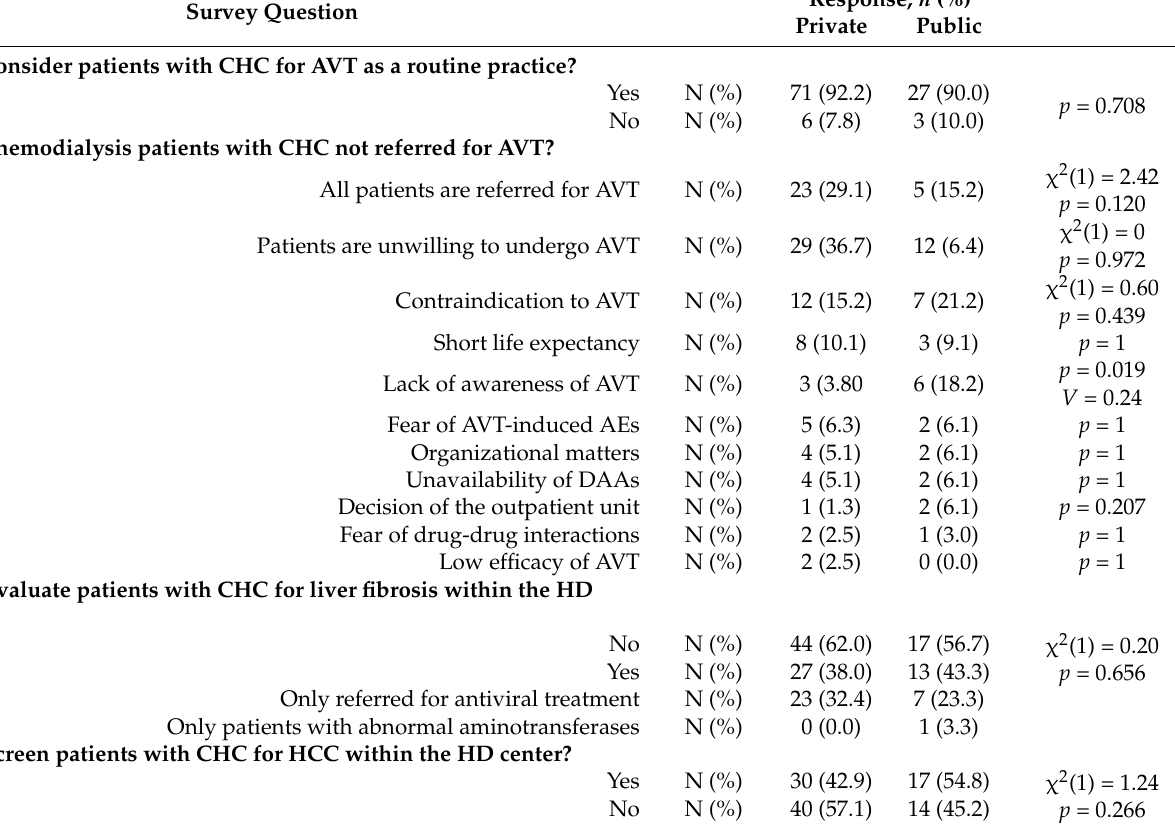
Table 3. Differences in HCV care between private and public hemodialysis centers in